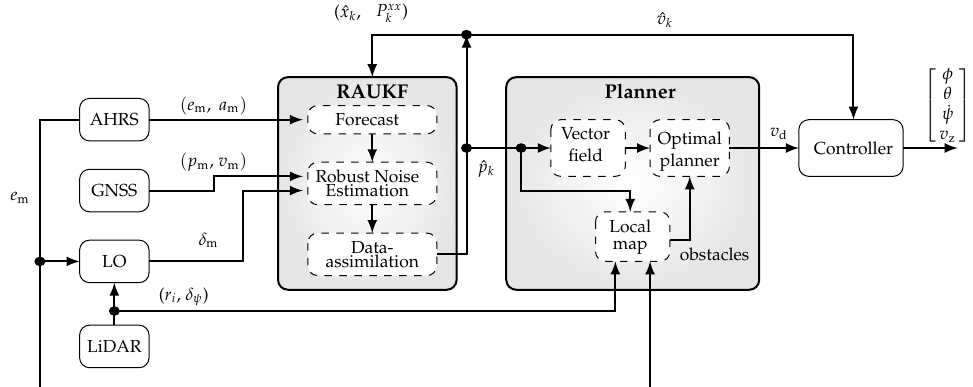
Figure 2. Block diagram of the proposed navigation solution. Data from the available sensors are combined using a robust and adaptive version of UKF (RAUKF). The filter outputs and estimates of position ˆ p k and velocity ˆ v k , feed the motion control system, which consists of a path planner and a velocity controller. The controller outputs are the MAV roll φ , pitch θ , yaw rate ˙ ψ , and vertical velocity v z , with respect to NED